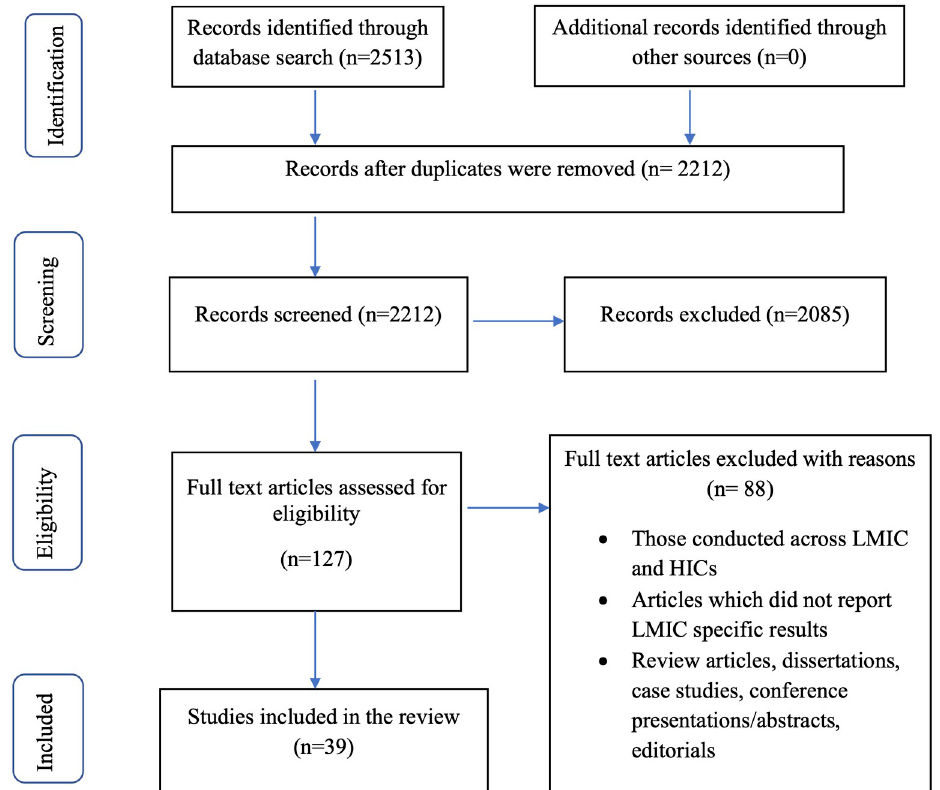
Fig 1. PRISMA Flowchart describing the selection of studies mapping existing literature on acceptability, feasibility, and effectiveness of telehealth interventions for SUDs in LMICs.